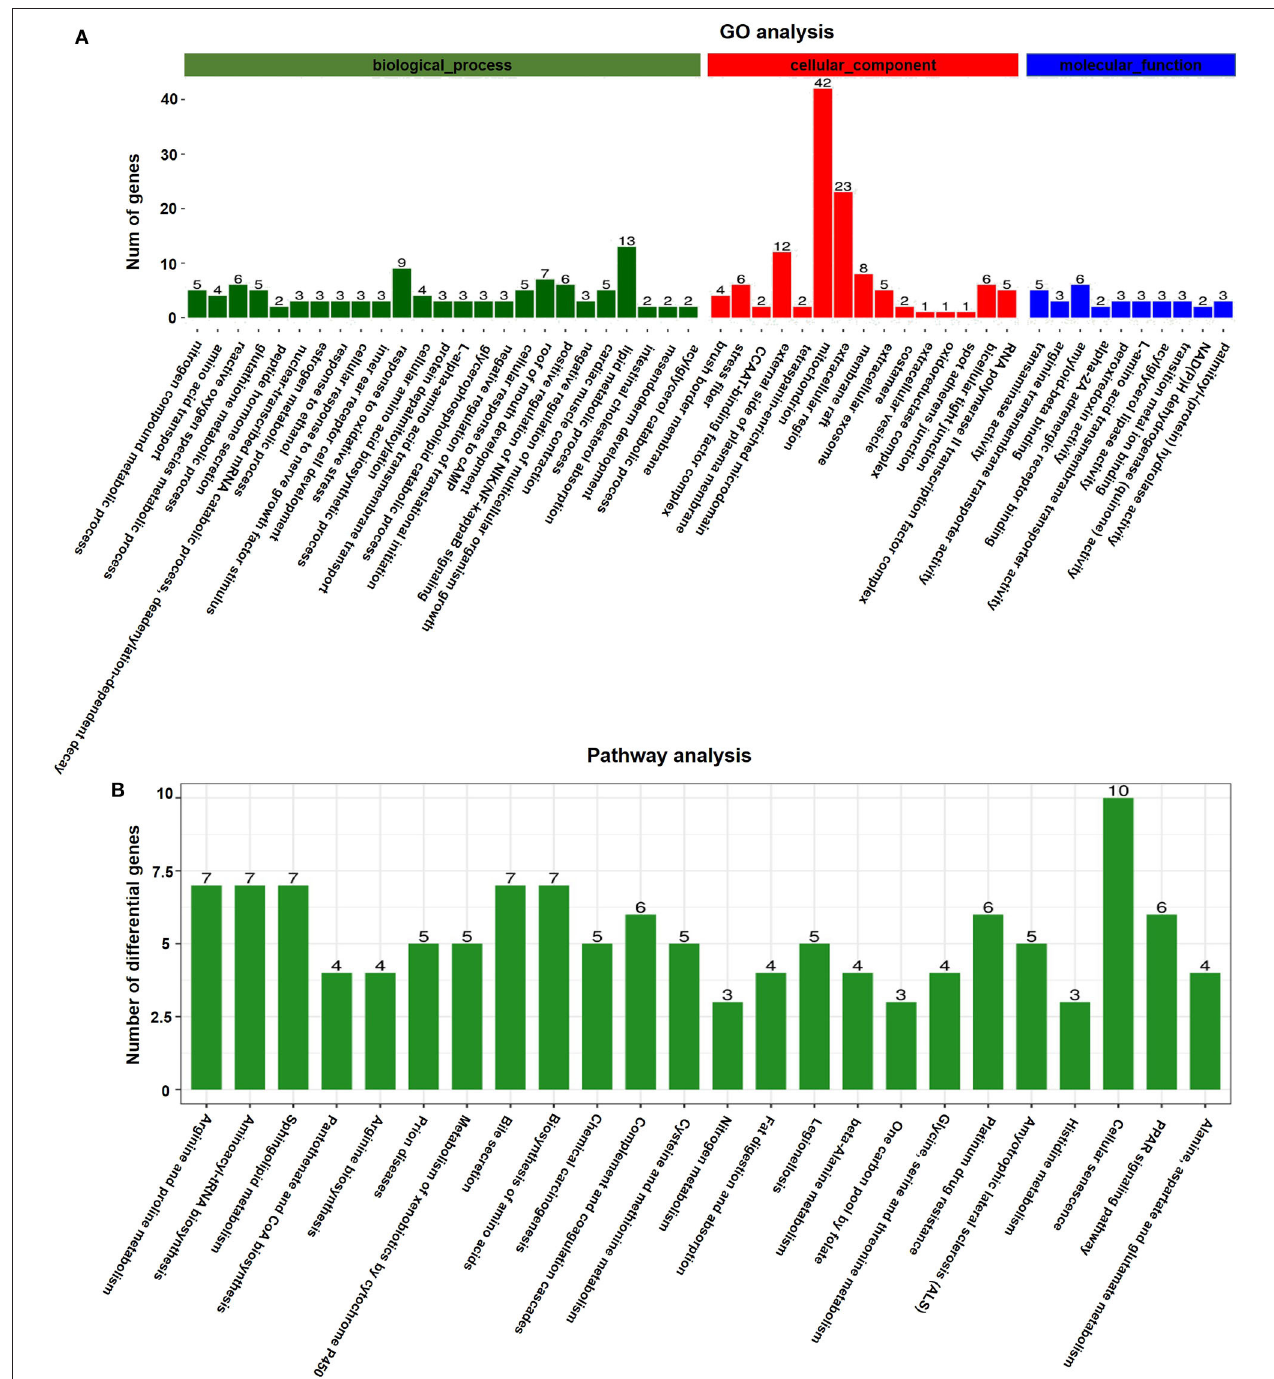
FIGURE 4 | Gene function analyses of vitrified/thawed porcine cloned blastocysts. (A) Distribution of gene ontology (GO) categories as per the three major GO domains. Genes were classified as per those related to biological processes (a), cellular components (b), and molecular functions (c). Bars represent the number of sequences in different GO categories. (B) KEGG annotation of differentially expressed genes (DEGs); 126 DEGs were subjected to KEGG annotation and were grouped into 24 pathway classes. The vertical axis shows the name of KEGG terms and the horizontal axis displays the number of DEGs. p < 0.05 was used as the threshold to select significant KEGG